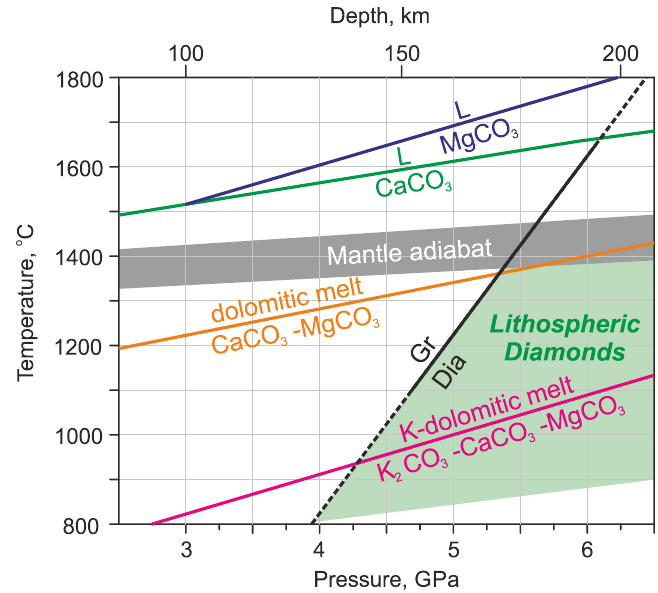
Figure 9. P–T plot illustrating solidus of the K 2 CO 3 –CaCO 3 –MgCO 3 and CaCO 3 –MgCO 3 systems and melting curves of CaCO 3 and MgCO 3 [35] compared with mantle adiabat [64] and P–T range of diamond growth in the lithospheric mantle [56]. Gr / Dia—the equilibrium boundary between diamond and graphite [65].